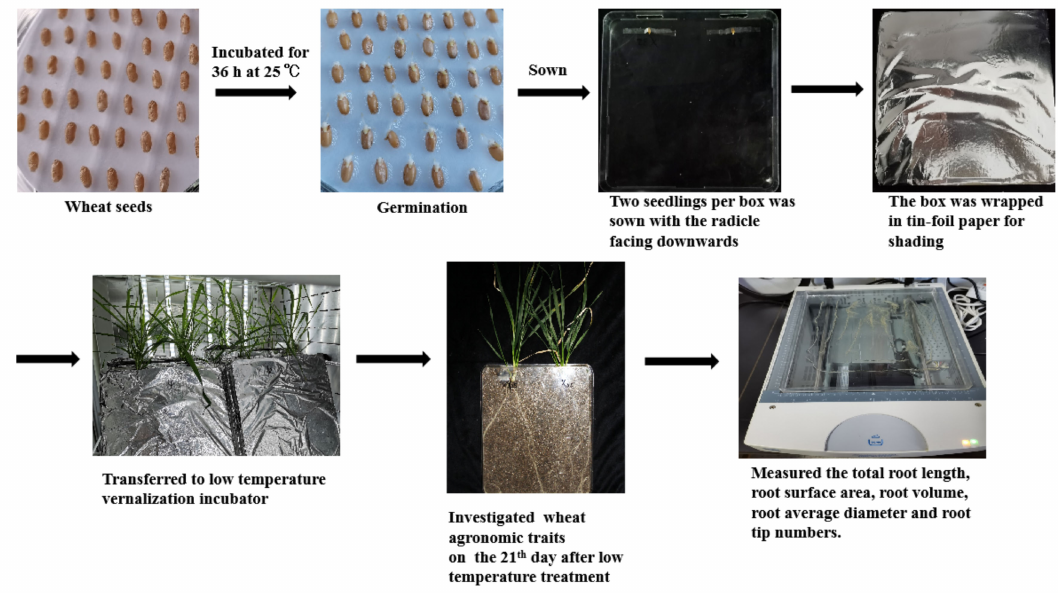
Figure 1. Overview of the experimental